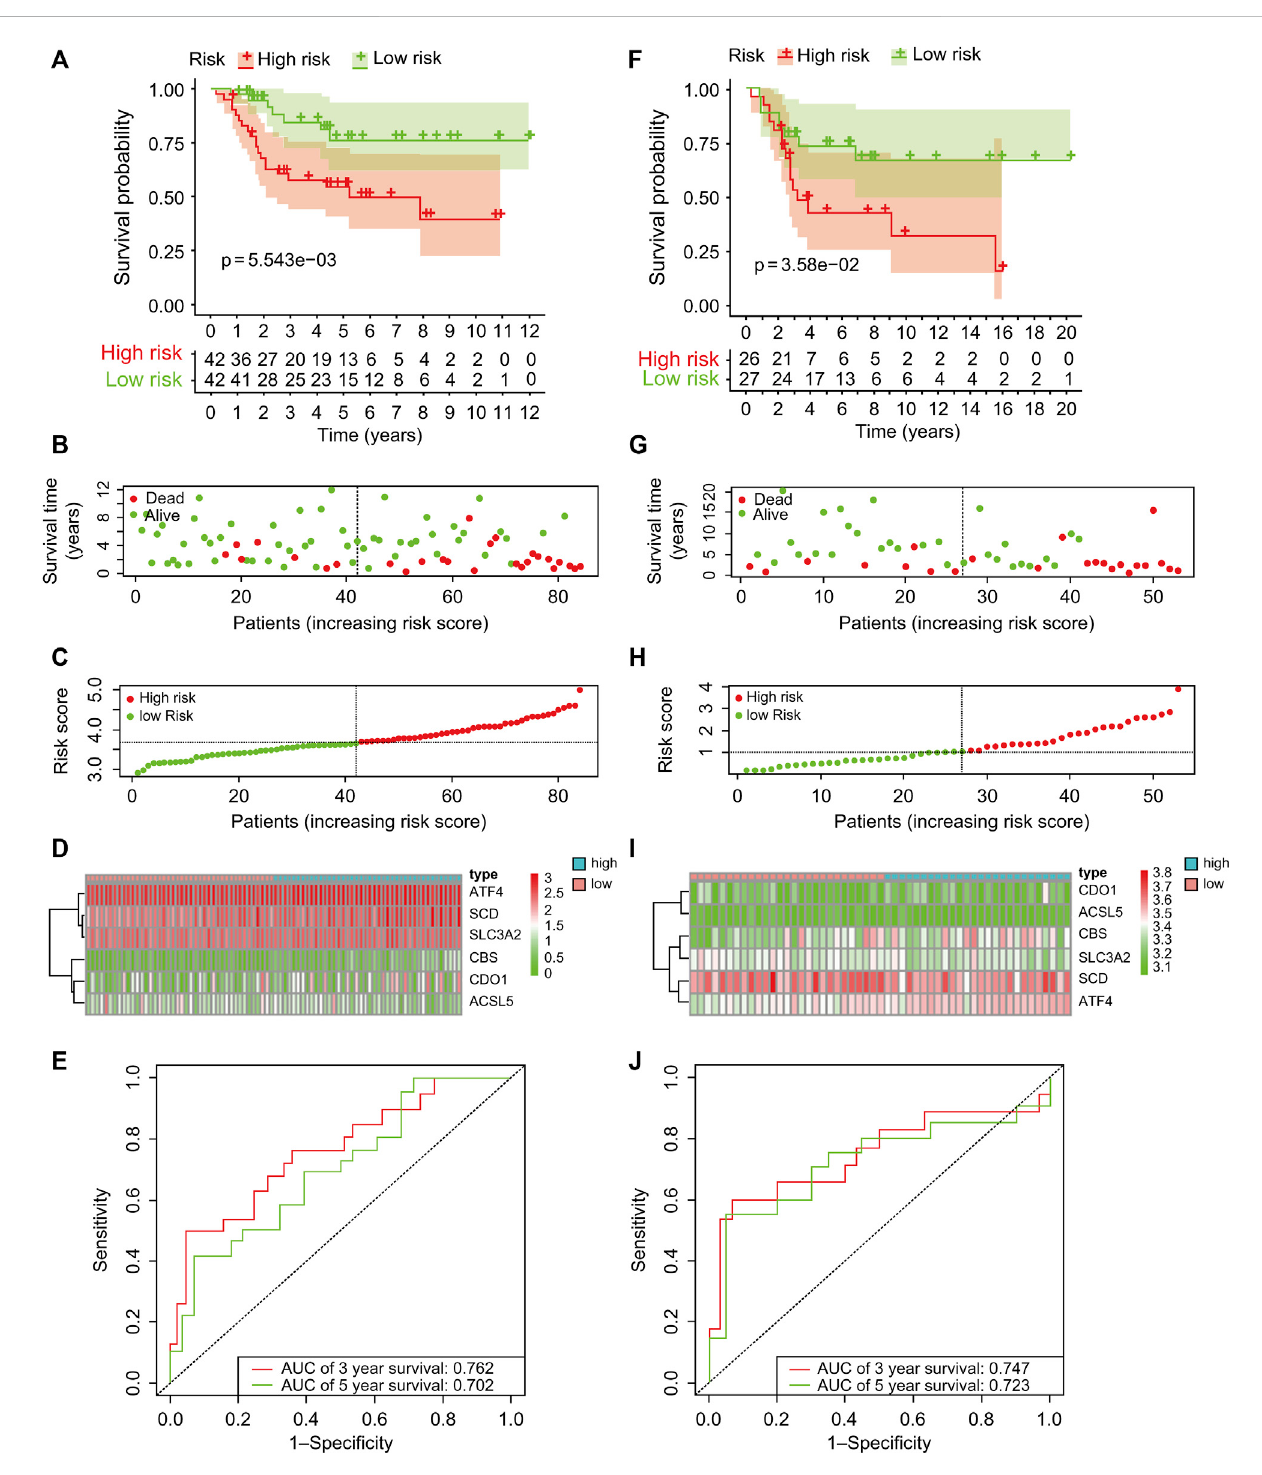
FIGURE 3 Kaplan – Meier survival analysis of patients with osteosarcoma in the test and validation sets of risk assessment models (A, F) showed that the high-risk group showed a signi fi cantly poor prognosis, and the low-risk group showed a good prognosis. (B, G) Survival of patients with osteosarcoma in the test and validationsets. (C,H) Distributionofriskscoresforsixgenesinosteosarcomapatientsintestandvalidationsets. (D,I) Heatmapsofsixgenesinlow-andhigh- risk groups for test and validation sets. (E, J) Receiver operating characteristic curve analysis and validation of patients with osteosarcoma in the test set. AUC, area under the